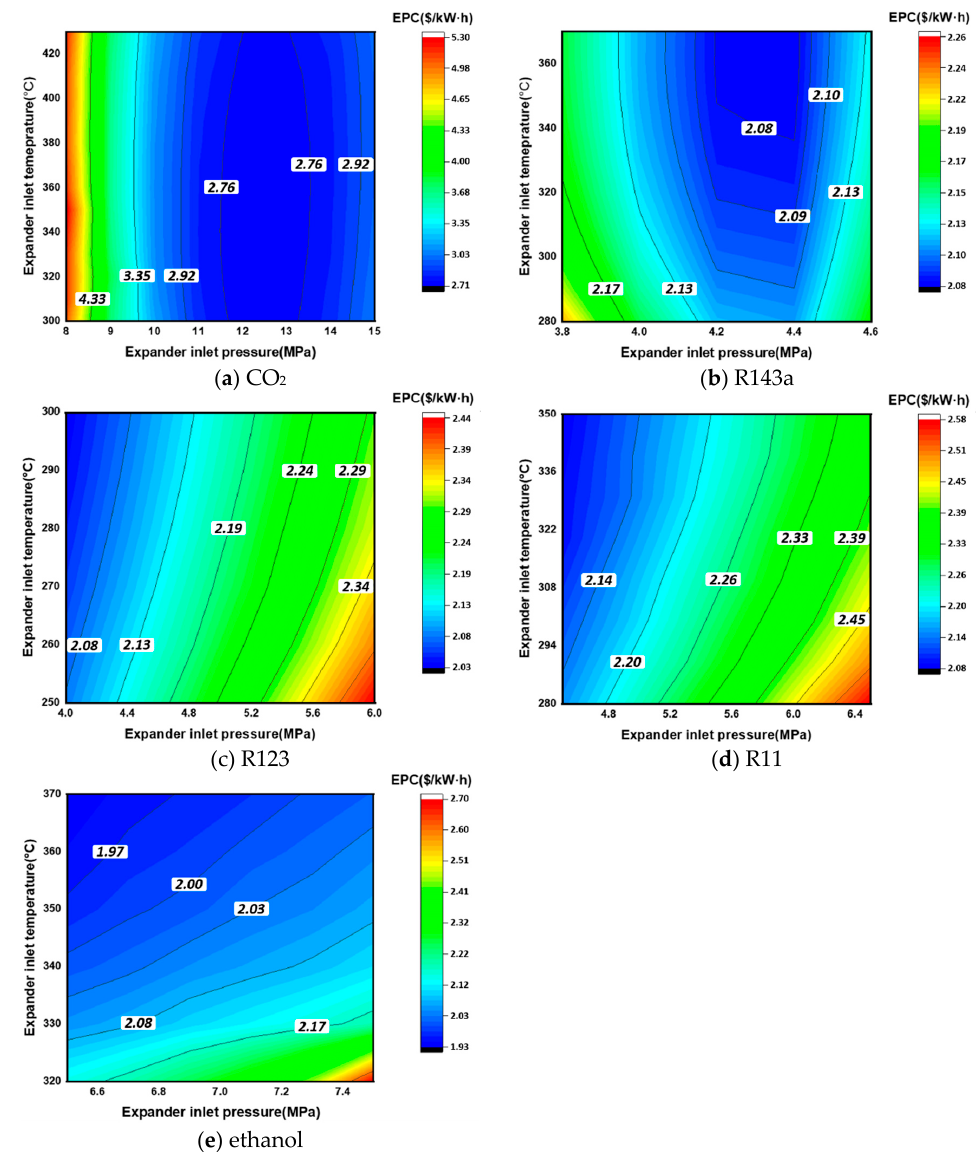
Figure 8. Effects of the expander inlet pressure and temperature on the electricity production cost: ( a ) CO 2 , ( b ) R143a, ( c ) R123, ( d ) R11, and ( e ) ethanol.